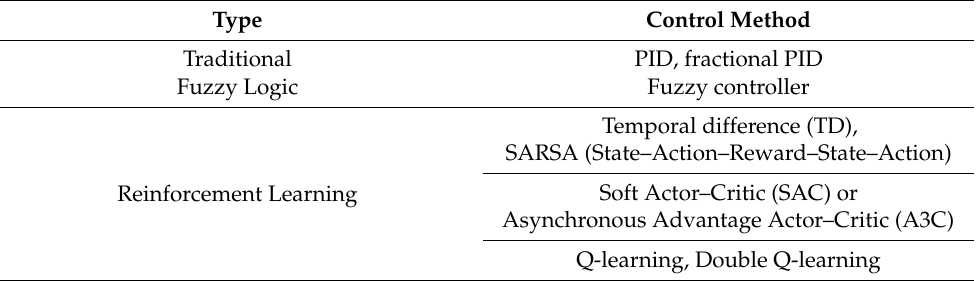
Table 3. Overview of common and new control algorithms.